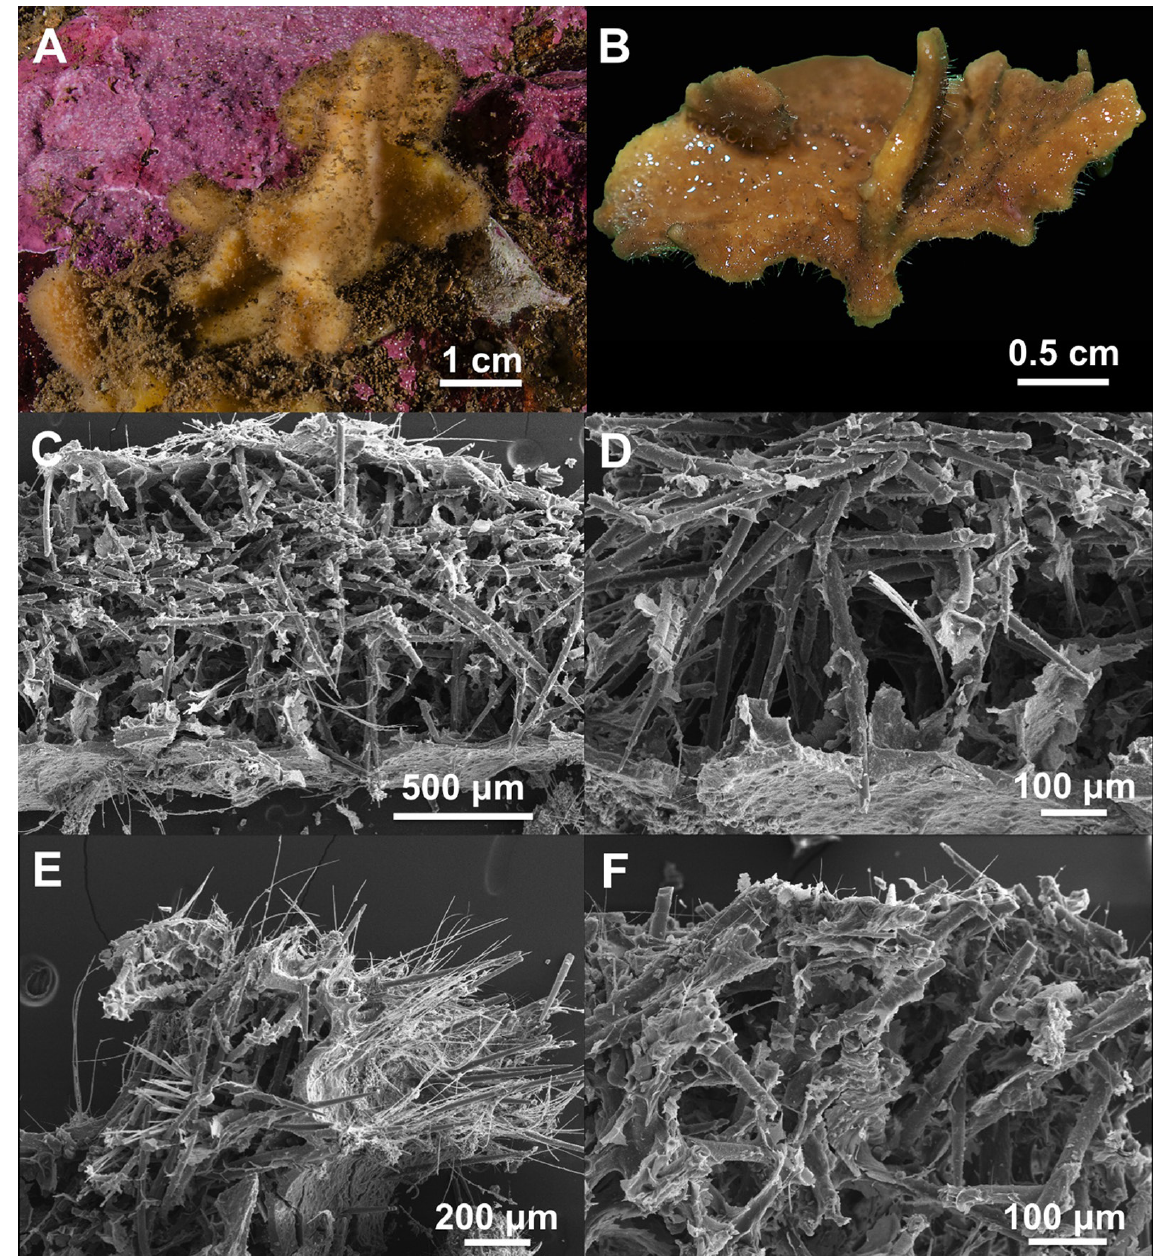
Fig. 9. Biemna erecta Bertolino, Costa & Pansini sp. nov., holotype (CILE 74; MSGN 61496). A–B . The holotype in life. C . Plumose skeleton. D–E . Choanosome. F . Basal peduncle